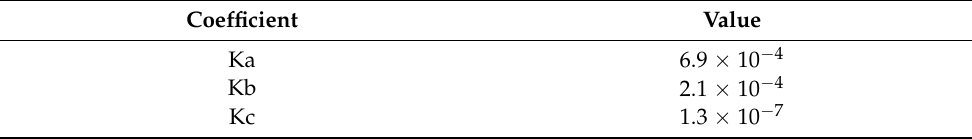
Table 4. Steinhart–Hart full model